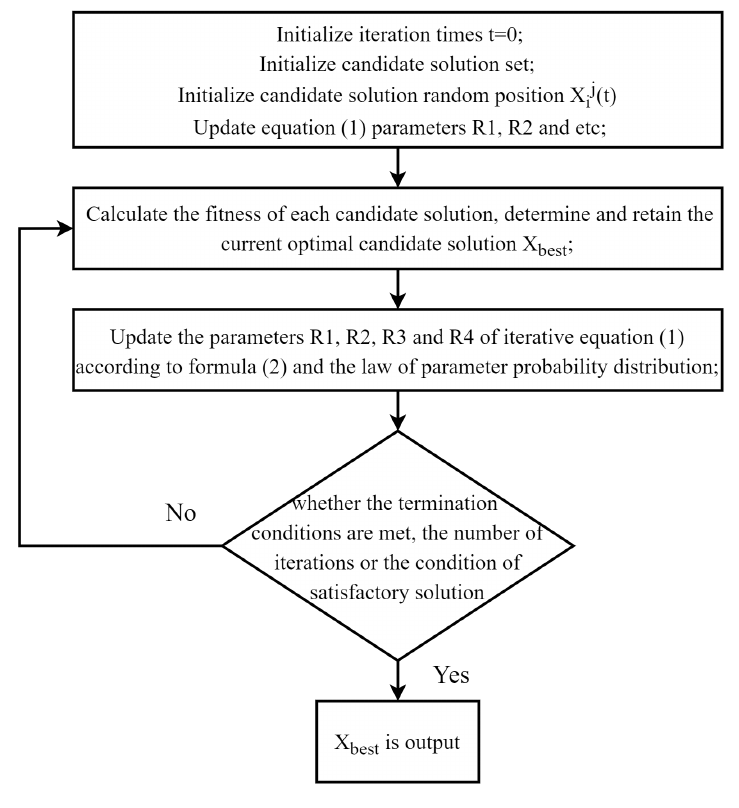
Figure 1. The flow chart of